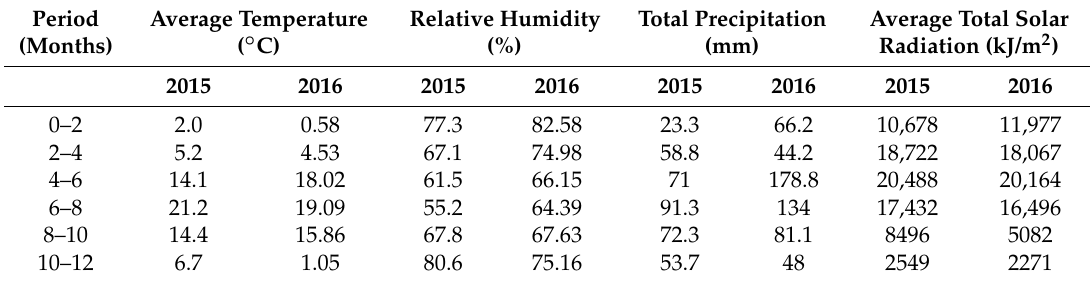
Table 2. Weather conditions during the natural weathering test. Values are based on data from a weather station